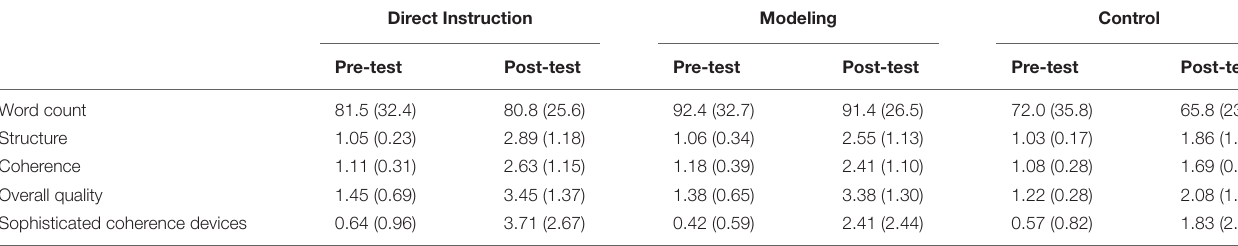
TABLE 2 | Effects of intervention on performance in the individual writing assessment task.